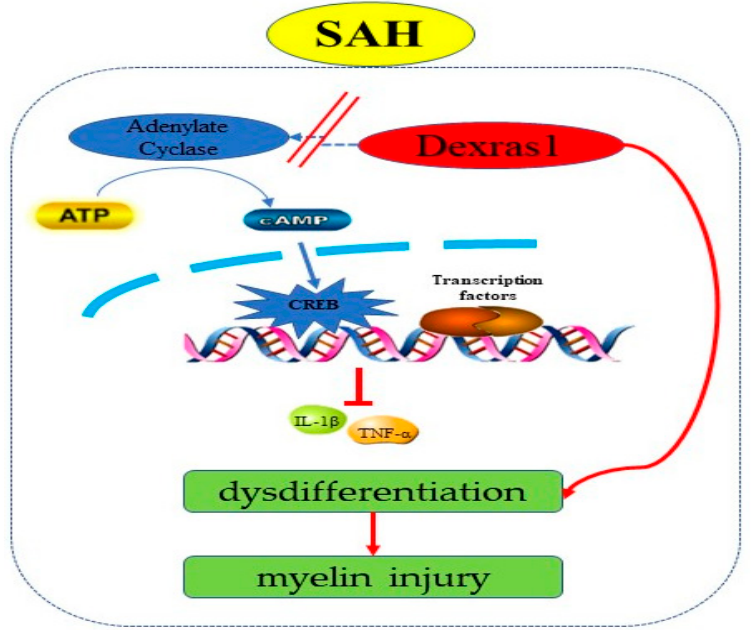
Figure 9. Schematic diagram of the regulatory role of Dexras1 in SAH.